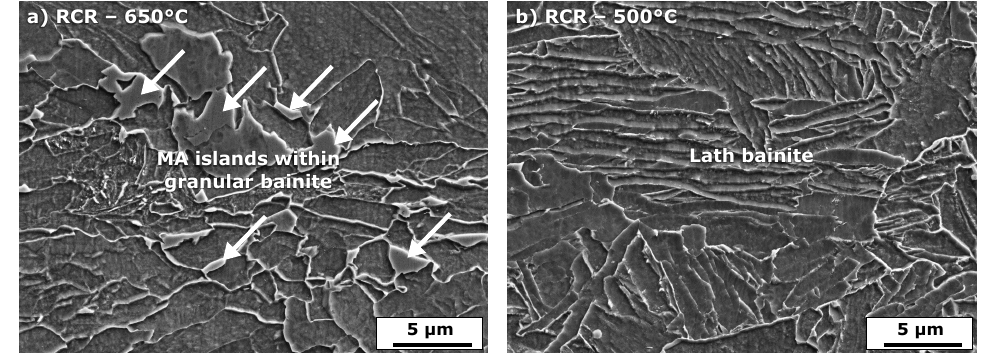
Figure 10. SEM observations of the microstructures of ( a ) RCR-650 ◦ C and ( b ) RCR-500 ◦ C hot-rolled plates. Nital